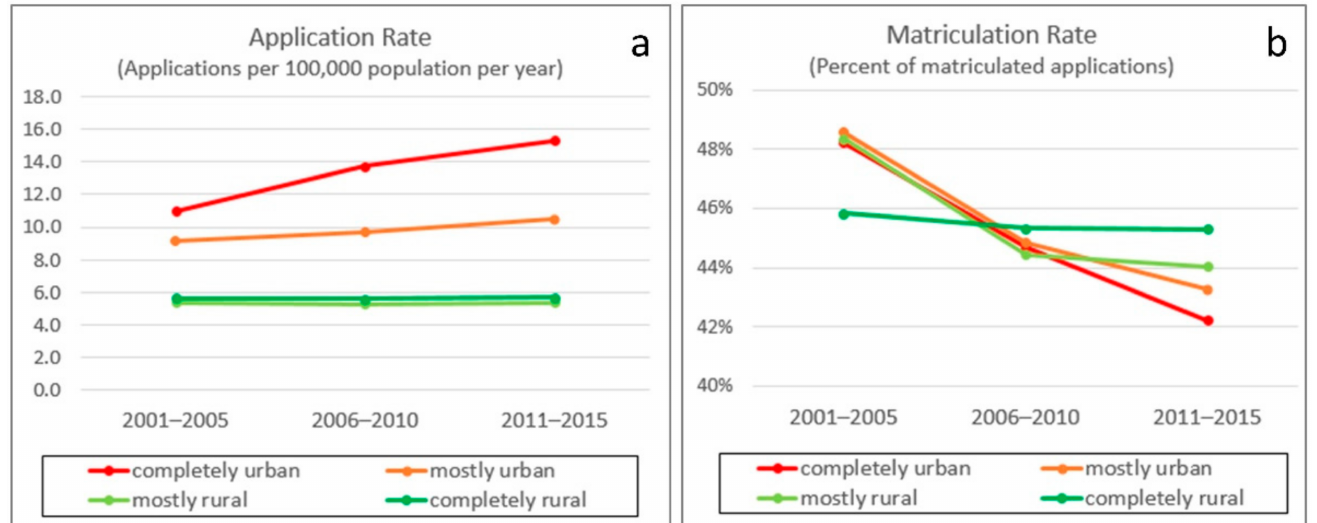
Figure 4. Application rate and matriculation rate. ( a ) Applications per 100,000 population per year, ( b ) the percent of matriculated